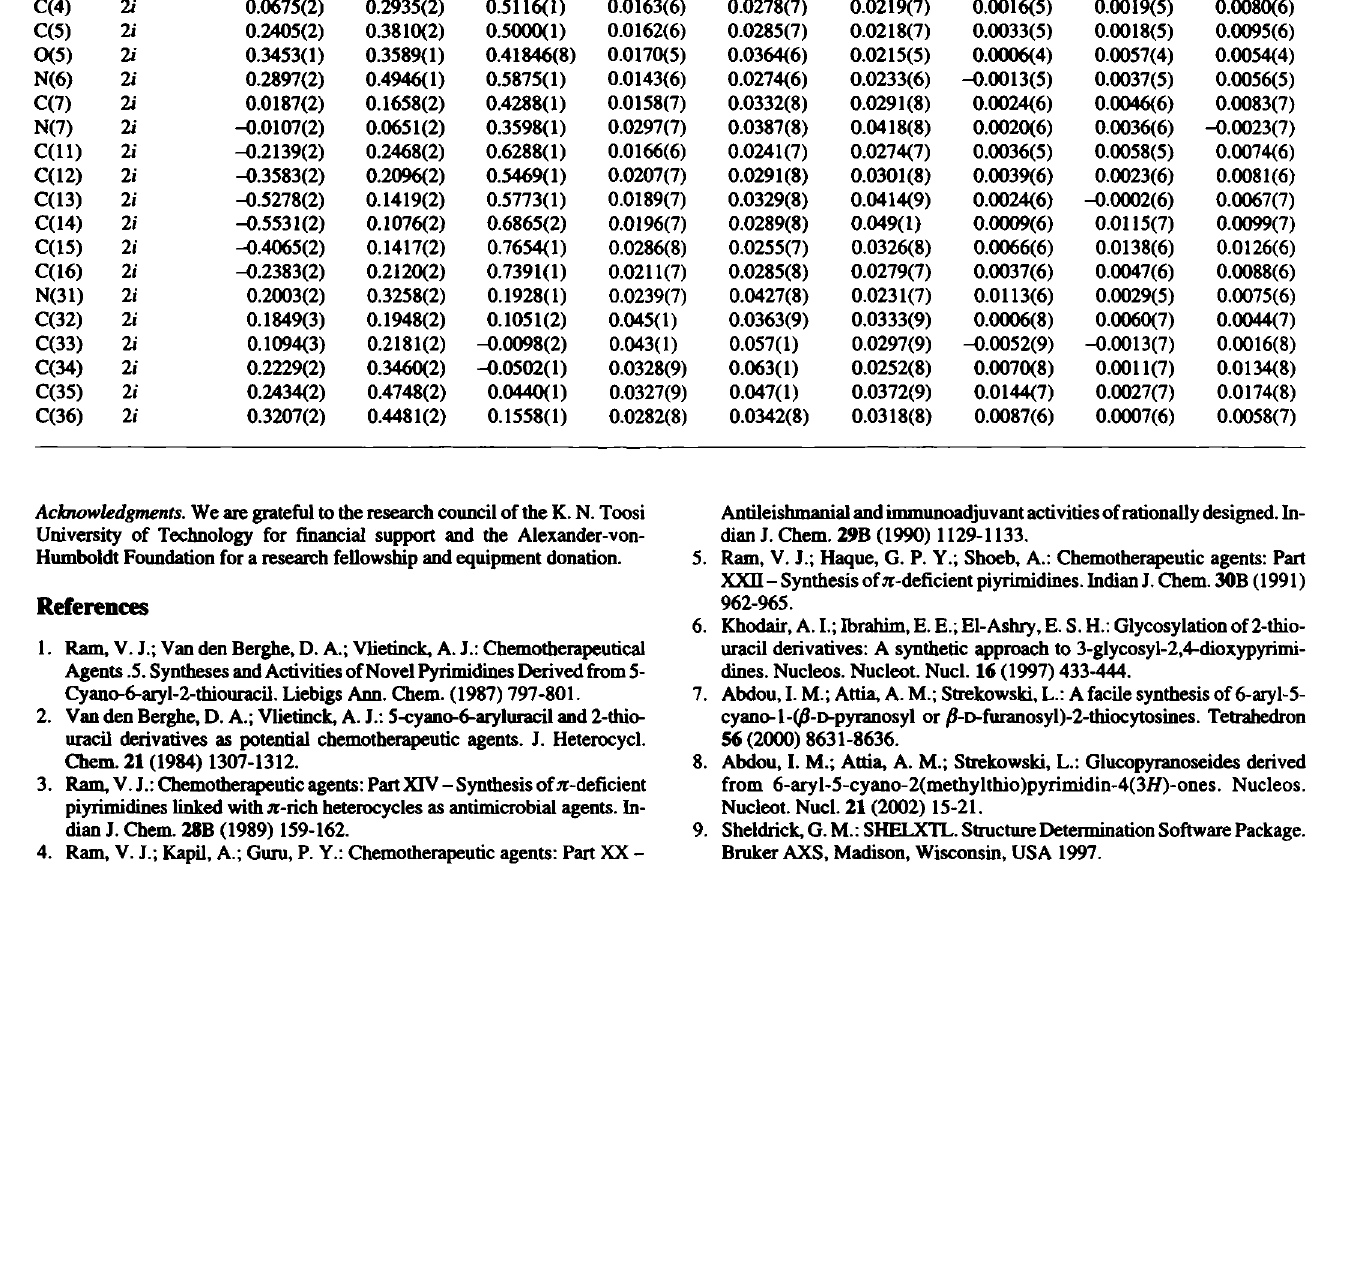
Table 3. Atomic coordinates and displacement parameters (in A 2